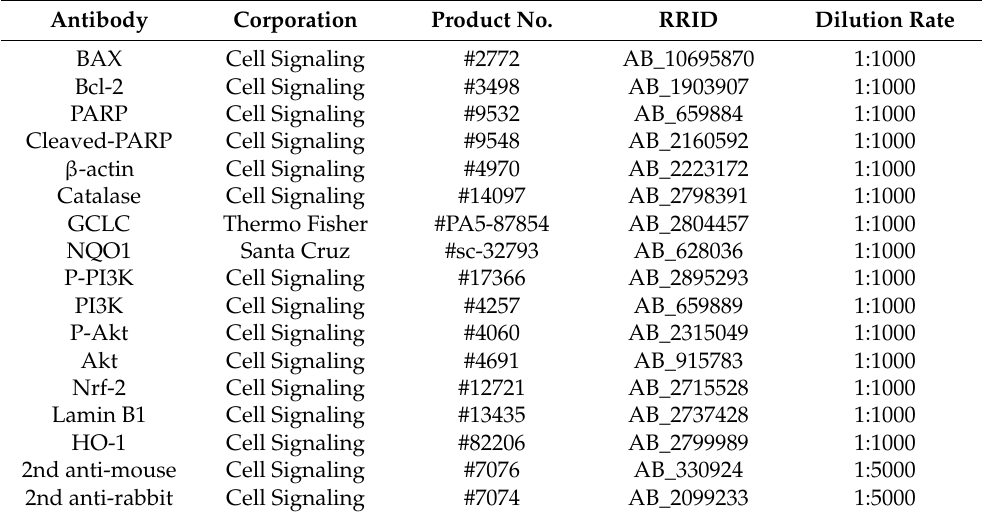
Table 1. Primary and secondary antibodies use for Western blot